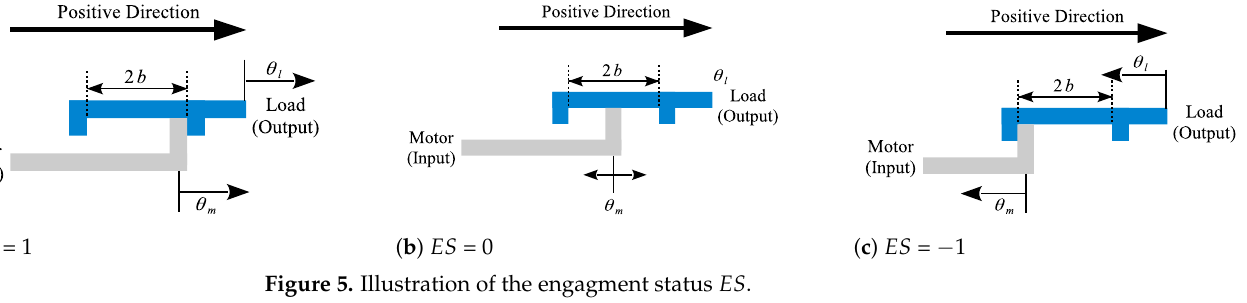
Figure 5. Illustration of the engagment status ES